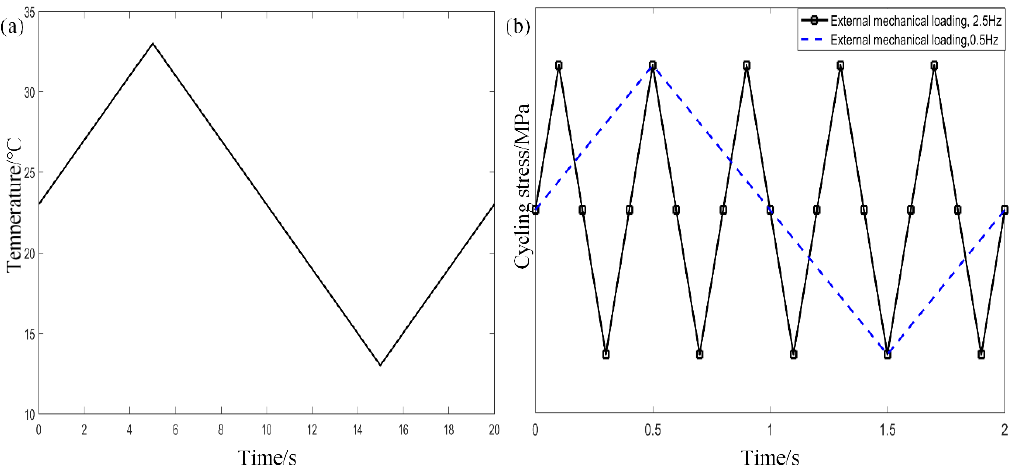
Materials 2019 , 12 , x FOR PEER REVIEW Figure 6. Loading modes on composites. ( a ) Temperature cycling. ( b ) Two typical mechanical loadings.